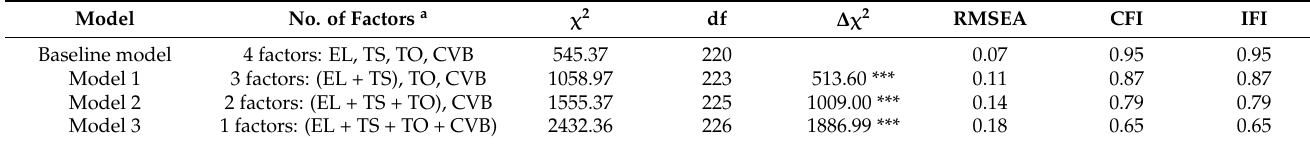
Table 4. Confirmatory factor analysis.